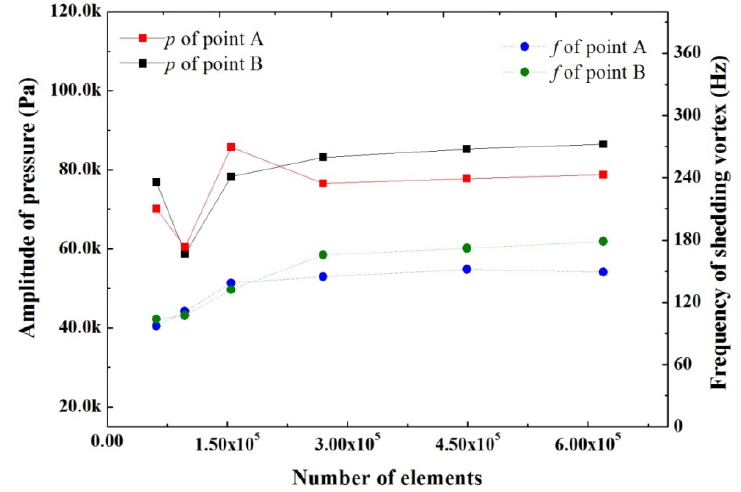
Figure 2. Mesh independence verification.